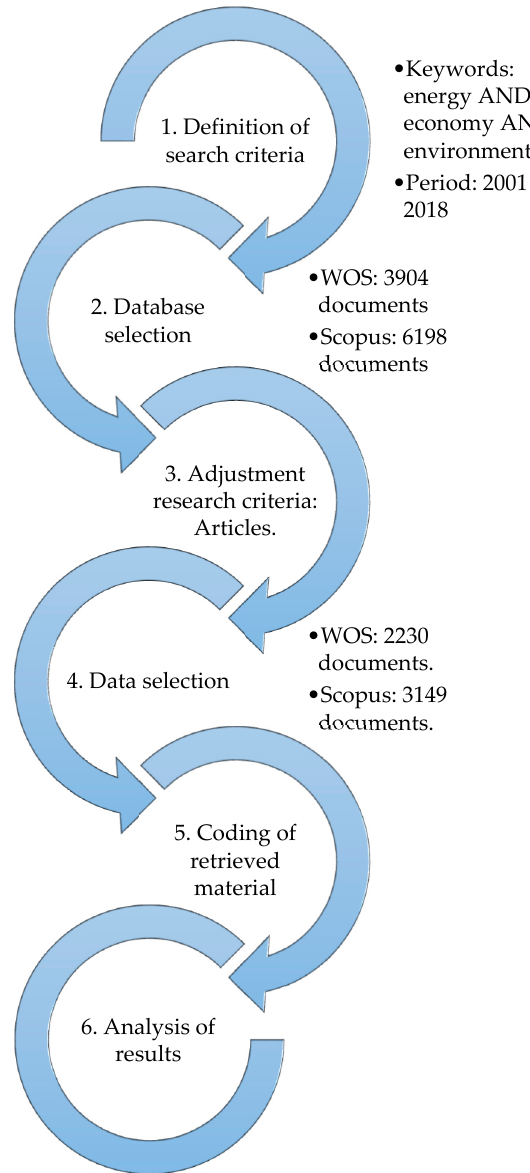
Figure 1. Bibliometric analysis steps followed.